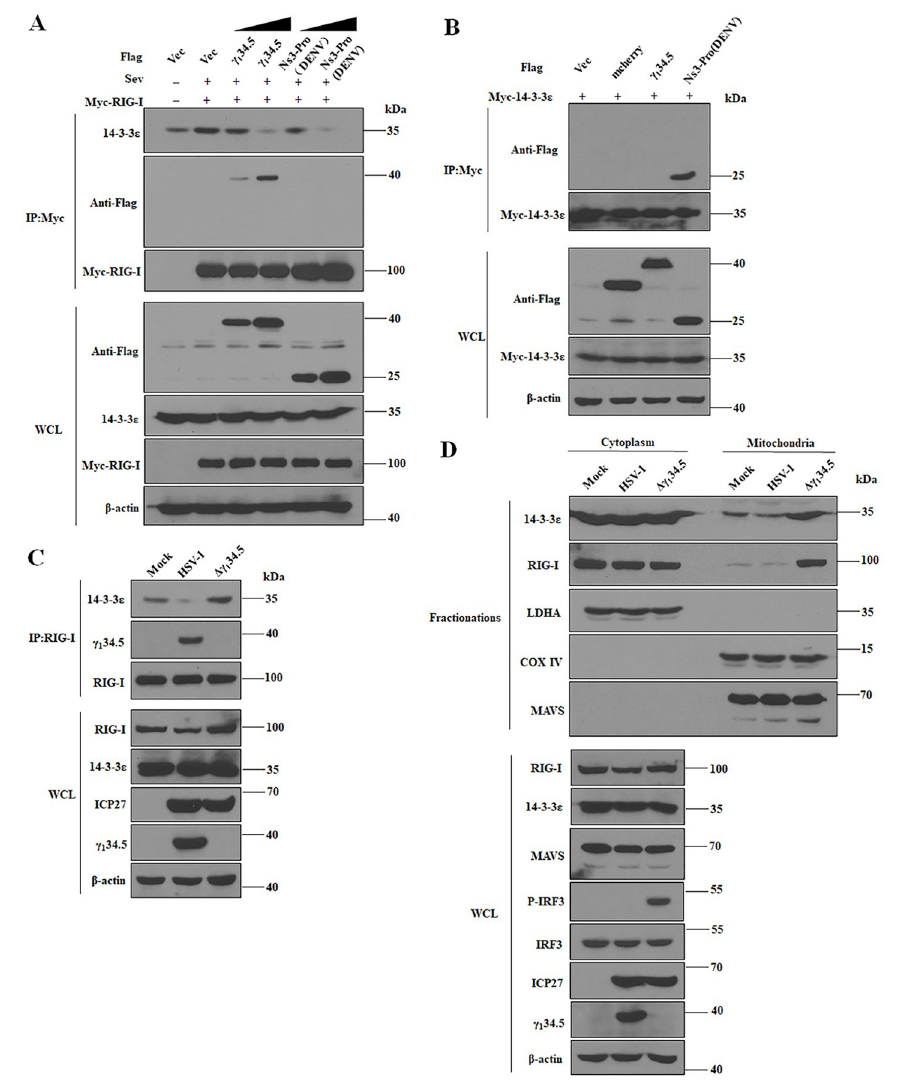
Fig 7. The γ 1 34.5 protein precludes formation of the RIG-I-14-3-3 ε complex required for mitochondrial translocation and IRF3 activation. (A) The γ 1 34.5 protein prevents the interaction of RIG-I and 14-3-3 ε . HEK-293T cells were transfected with Myc-RIG-I together with vector plasmid or Flag- γ 1 34.5 or lag-Ns3-pro (DENV). At 24 h posttransfection, cells were treated with SeV (100HA/ml) for 24 h. Whole-cell lysates (WCLs) were subjected to immunoprecipitation (IP) with anti-Myc antibody. Precipitated proteins and WCLs were probed with antibodies against Flag, Myc, 14-3-3 ε and β -actin. (B) The γ 1 34.5 protein dose not interact with 14-3-3 ε . HEK-293T cells were co- transfected with Myc-14-3-3 ε along with vector plasmids, Flag-mCherry, Flag- γ 1 34.5 and Flag-Ns3-pro (DENV) for 36 h. Cells were then harvested and subjected to immunoprecipitation (IP) with anti-Myc antibody. Precipitated proteins and WCLs were probed with antibodies against Flag, Myc, and β -actin. (C) Inhibition of the RIG-I-14-3-3 ε complex formation by HSV-1 requires γ 1 34.5. MEFs were infected with wild type HSV-1 or Δγ 1 34.5 (10 pfu/cell). At 8 h postinfection, cells were processed for immunoprecipitation (IP) with anti-RIG-I antibody. Whole-cell lysates and precipitated proteins were probed with antibodies against RIG-I, 14-3-3 ε , γ 1 34.5, ICP27 and β -actin. (D) Block of RIG-I mitochondrial translocation by γ 1 34.5 inhibits IRF3 phosphorylation. MEFs were infected with wild type HSV-1 or Δγ 1 34.5 (10 pfu/cell). At 8h postinfection, cells were harvested for cytoplasmic and mitochondrial fractionation. Samples were processed for Western analysis with antibodies against 14-3-3 ε , RIG-I, LDHA, COX IV MAVS, phosphorylated IRF3, IRF3, ICP27, γ 1 34.5 and β -actin. The data are representative of results from three independent experiments.